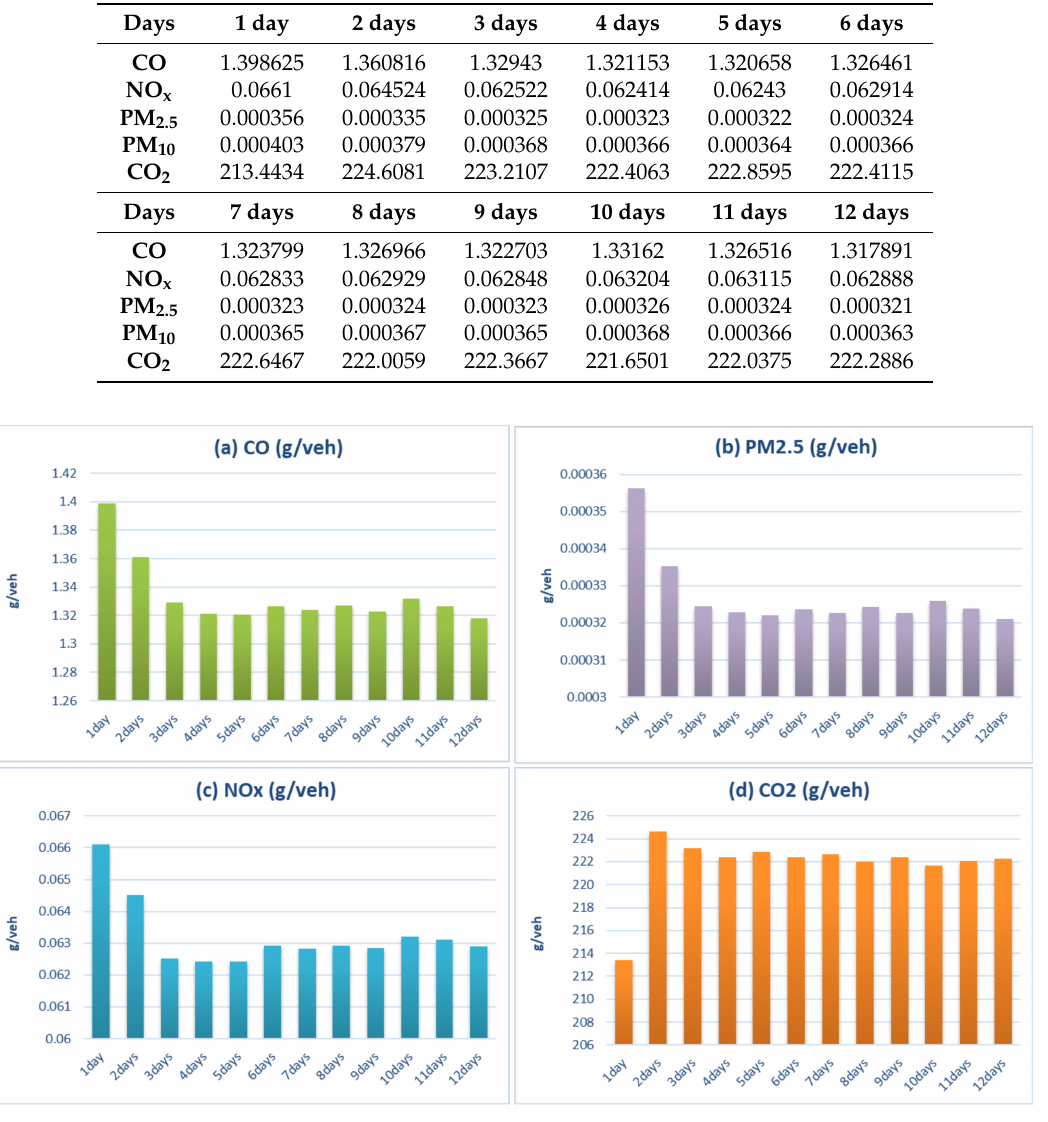
Figure 5. Changes in Estimated Link Emission Factors by Increasing Number of Data Collection